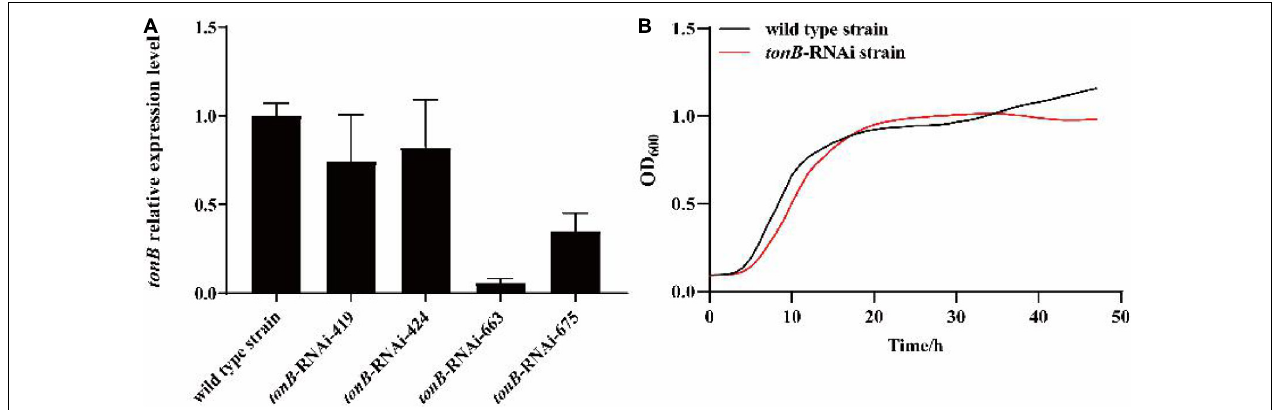
FIGURE 1 | Construction and growth curve of the tonB -RNAi strain of Pseudomonas plecoglossicida . (A) The tonB mRNA levels of four mutant strains. (B) Growth curve of the wild-type strain and tonB -RNAi strain.